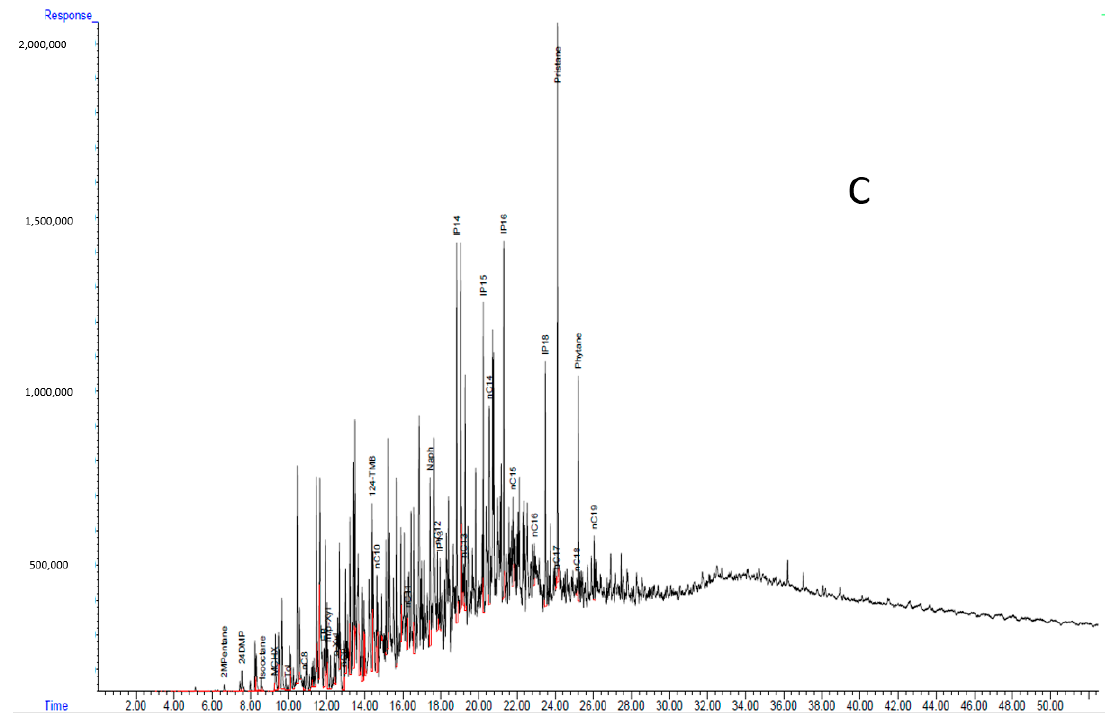
Figure 1. GC–FID analysis of the obtained LNAPL samples. Analysis of diesel- ( A ), jet-fuel- ( B ), and crude-oil- ( C ) contaminated cores. CHX—cyclohexane, Cs—straight or branched alkane containing x carbons, EB—ethylbenzene, IP—isoprenoid, Tol—toluene, and Xyl—xylene.